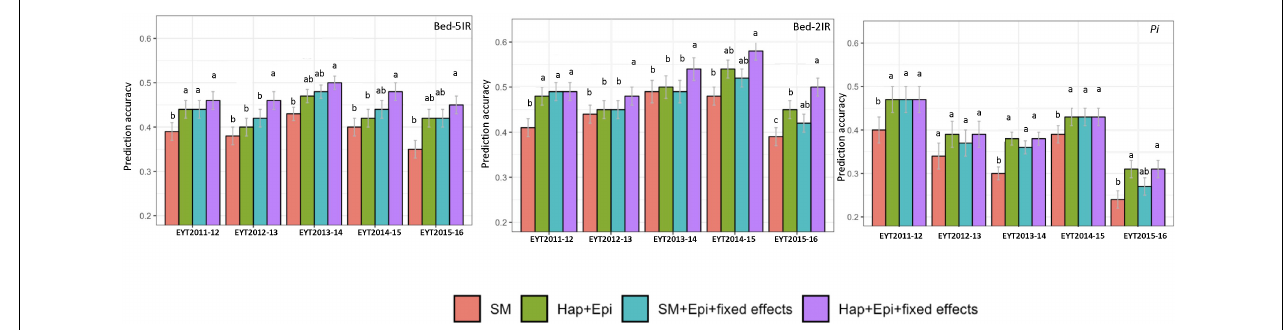
FIGURE 4 | Genomic predictions values for GY (from two illustrative environments B-5IR and B-2IR) and Pi . SM, Genome-wide SNPs; H + E, Genome-wide haplotypes + epistatsis; SM + E + GWAS, Genome-wide SNPs + epistasis + fixed effects; and H + E + GWAS, Genome wide haplotypes + epistasis + fixed effects. The whisker line above columns represents LSD